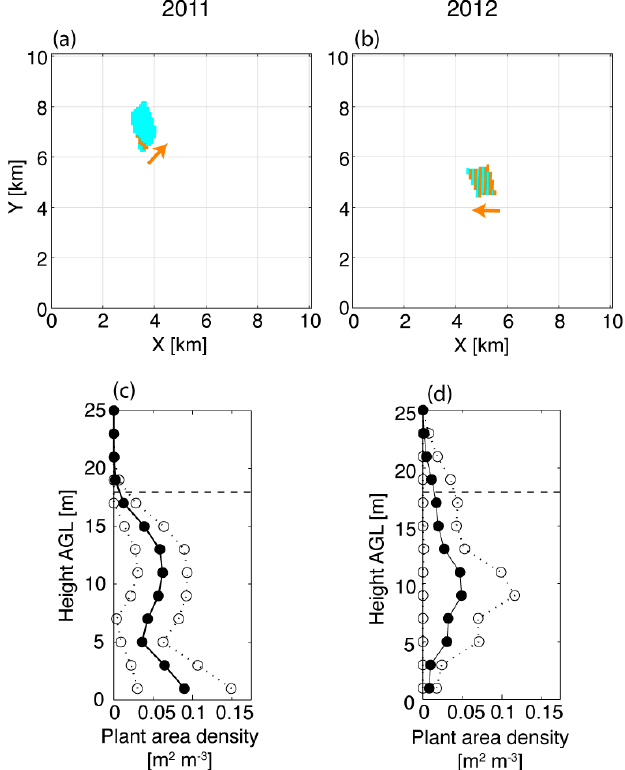
Figure 1. ARPS-CANOPY burn unit schematics (panels a , b ) and plant area density profiles (panels c , d ) for the 2011 and 2012 cases. In the burn unit schematics, blue shading indicates the ARPS-CANOPY burn unit and orange shading indicates cells where the fire heat source is applied [arbitrary time in figure], with arrows indicating the general direction of simulated fire propagation during each event. In the plant area density profiles, the solid line/filled circles are domain-average values and the dashed line/hollow circles show +/ − one standard deviation. The horizontal dashed line denotes 18 m AGL, which is the approximate domain-average height of the simulated canopy. Plant area density is derived from LiDAR measurements